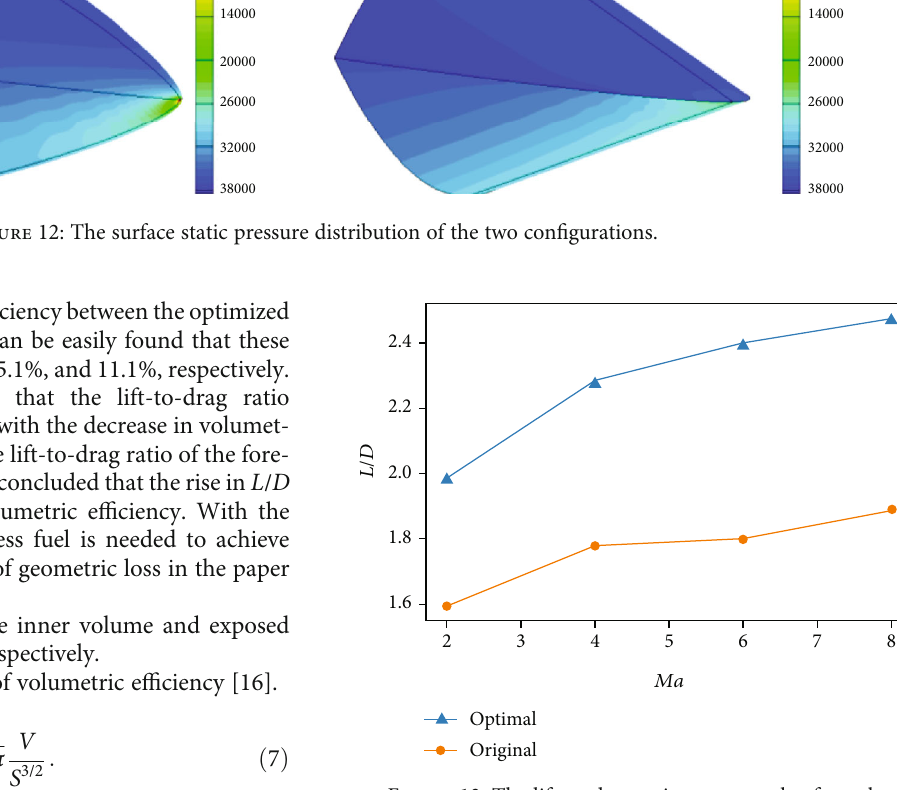
Figure 13: The lift-to-drag ratio versus angle of attack.